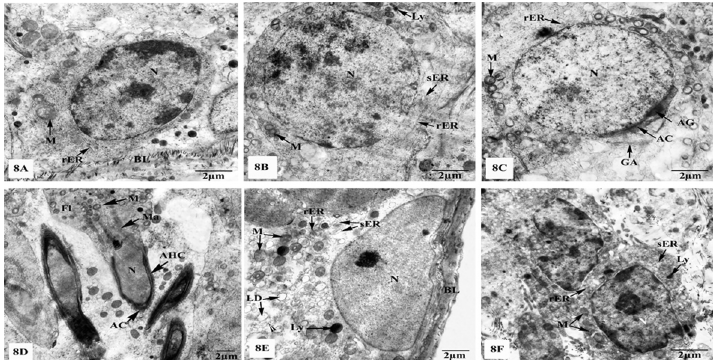
Figure 8. Electron micrographs of the testes of melatonin + taxol (MLT + TXL)-treated rats showing ( A ) nearly normal spermatogonium resting upon basal lamina (BL), and possesses oval nucleus (N), mitochondria (M), and rough endoplasmic reticulum (rER); ( B ) intact primary spermatocyte with N, M, rER, smooth endoplasmic reticulum (sER), and lysosomes (Ly); ( C ) regular rounded spermatid with intact N, acrosomal granule (AG), acrosomal cap (AC), Golgi apparatus (GA), vacuolated M, and rER; ( D ) nearly normal elongated spermatids with regular acrosomal head caps (AHC), N, AC, manchettes (Ma), fl agella (Fl), and M; ( E ) well-developed Sertoli cell laying on a thin BL with N, rER, sER, M, free ribosomes ( c ), and lipid droplets (LD); ( F ) interstitium with Leydig cells appeared with prominent N and cytoplasmic organelles including M, rER, sER, and Ly. Scale bar 2 m